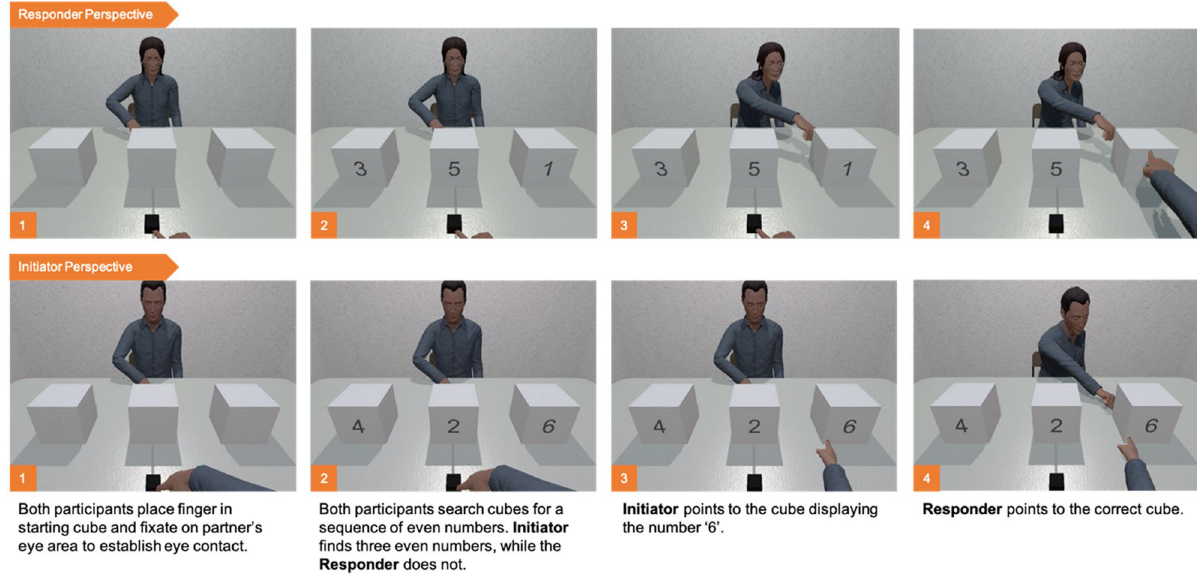
Figure 3. Example trial sequence representing the joint attention task from the perspective of the Initiator and